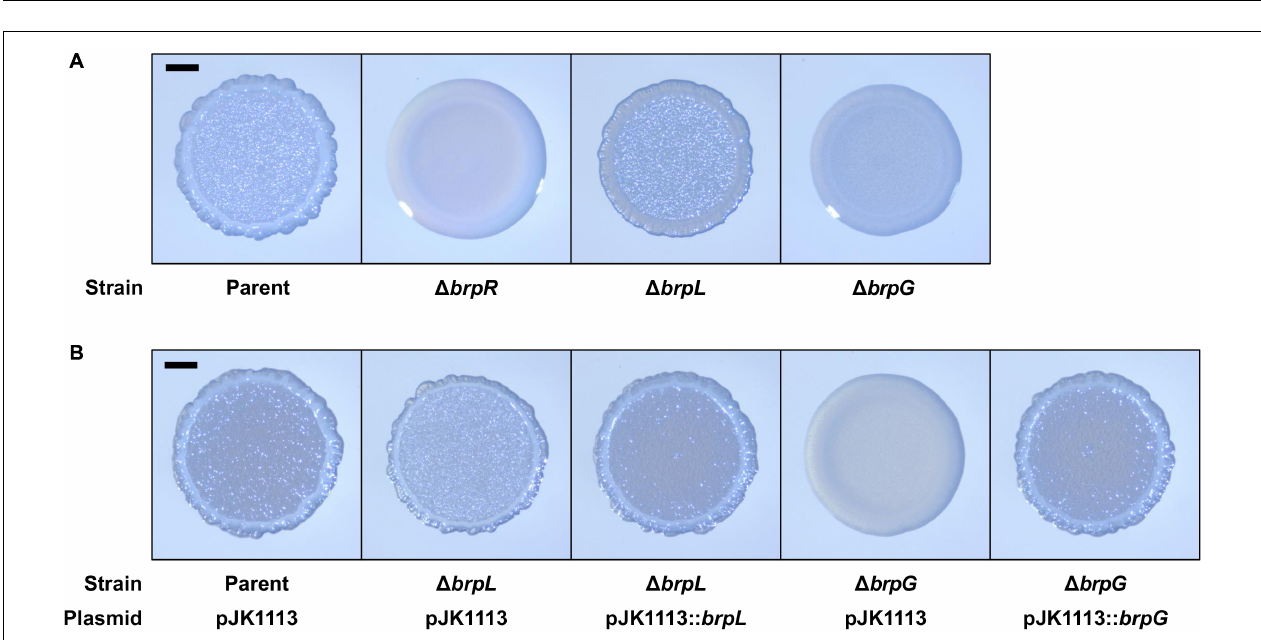
FIGURE 5 | Biofilm formation impaired by the deletion of brpLG . (A) Biofilms of the parent and mutant strains were grown in VFMG supplemented with 0.01% arabinose for 24 h, and then stained with 1% crystal violet. The crystal violet was eluted and its absorbance at 570 nm ( A 570 ) was determined to quantify the biofilms. (B) Biofilms of the parent and mutant strains were grown in VFMG supplemented with 0.01% arabinose and 100 µ g/ml kanamycin for 24 h for complementation experiments. The biofilm formation was quantified in the same manner as described above. Error bars represent the SD. Statistical significance was determined by the Student’s t test (**, P < 0.005; ns , not significant).